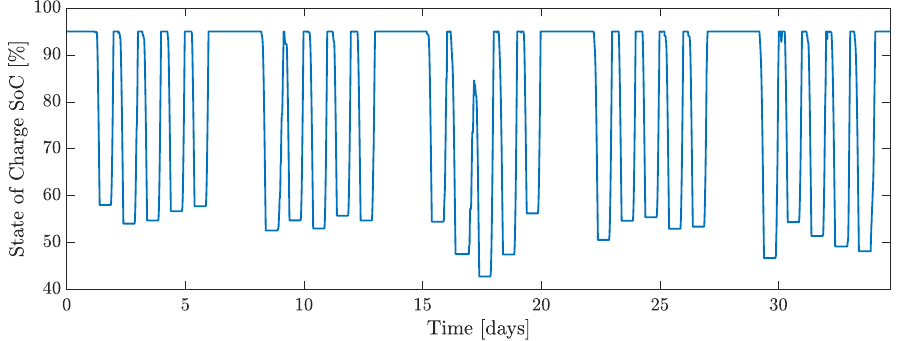
Figure 8. Excursion of the SoC during a